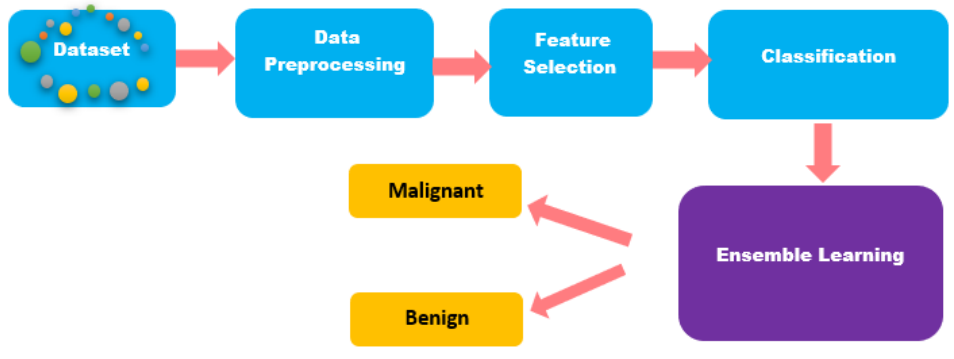
Figure 1. Proposed methodology for accurate breast cancer tumor